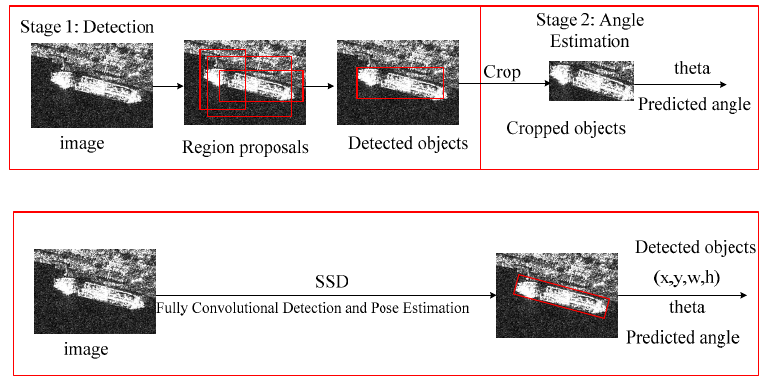
Figure 1. The above is the traditional two-stage method. It detects ships in Stage 1 and estimates their angles in Stage 2. The bottom is the proposed one-stage method. The angle estimation is embedded into the SSD detector, and the category, position, and angle are given through only one